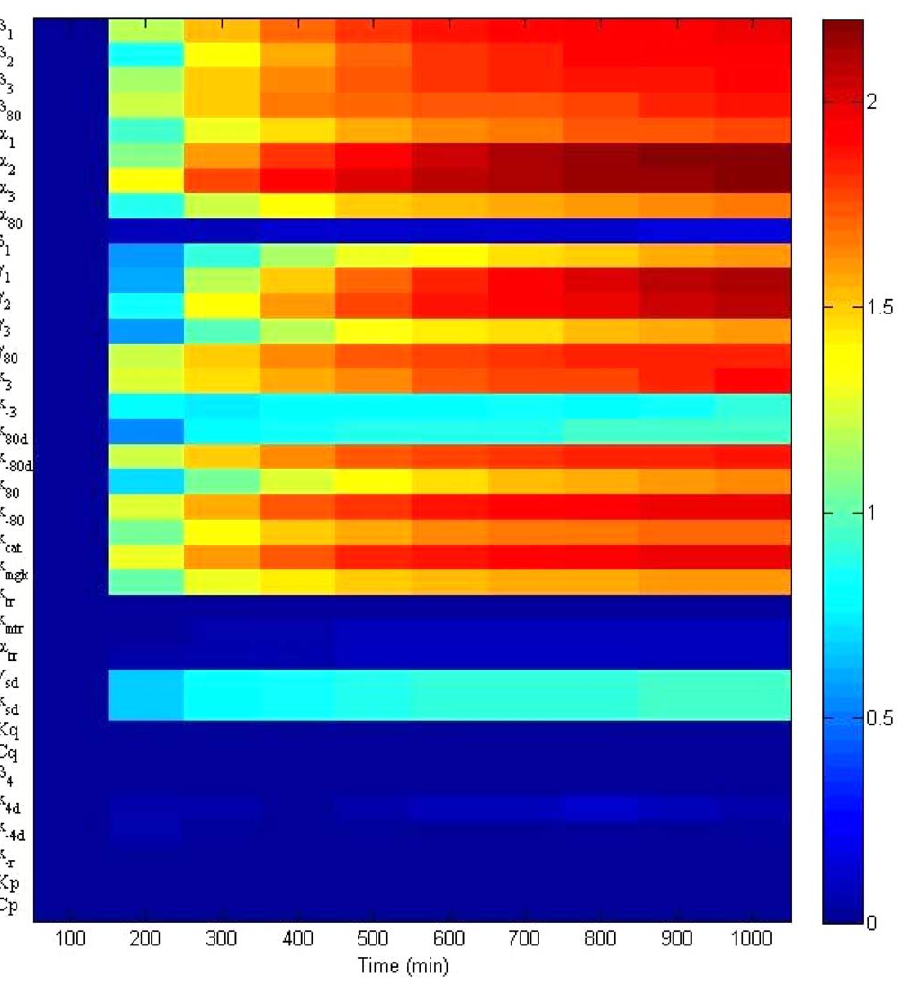
Figure 3. Local sensitivity analysis at the steady states of four GAL mRNAs with respect to all model parameters. The heat map denotes the average absolute value of the normalized sensitivity coefficients of four GAL mRNA across 1000 minutes. The parameters d 1 , a tr , v sd , k sd , b 4 , k 4 d , k { 4 d , k { r , k r , K p , and C p are smaller than 0.25, while the others are larger than 1. This implies the reaction terms associated with insensitive parameters can be omitted no matter which mRNA is chosen as the control target. One can conclude not only that the control model targeting GAL 1 mRNA need not include the terms associated with the above parameters, but also that control strategies targeting all four GAL mRNAs can suppress the same terms. The reduced model can thus be used for the control design targeting any of the four GAL mRNAs.